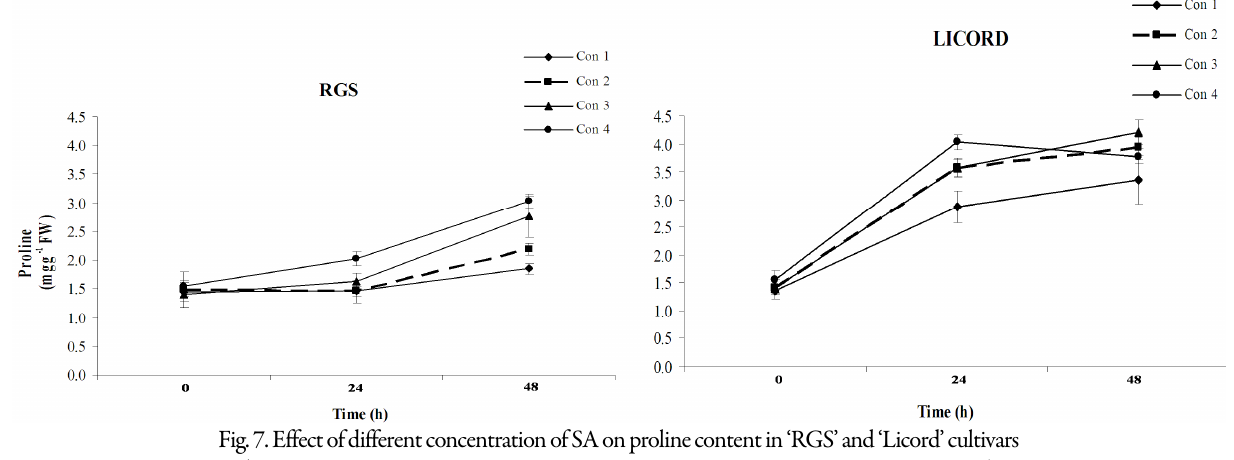
Fig. 7. Effect of different concentration of SA on proline content in ‘RGS’ and ‘Licord’ cultivars (Con 1-0 µM/L SA; Con 2-100 µM/L SA; Con 3-200 µM/L SA; Con 4-400 µM/L